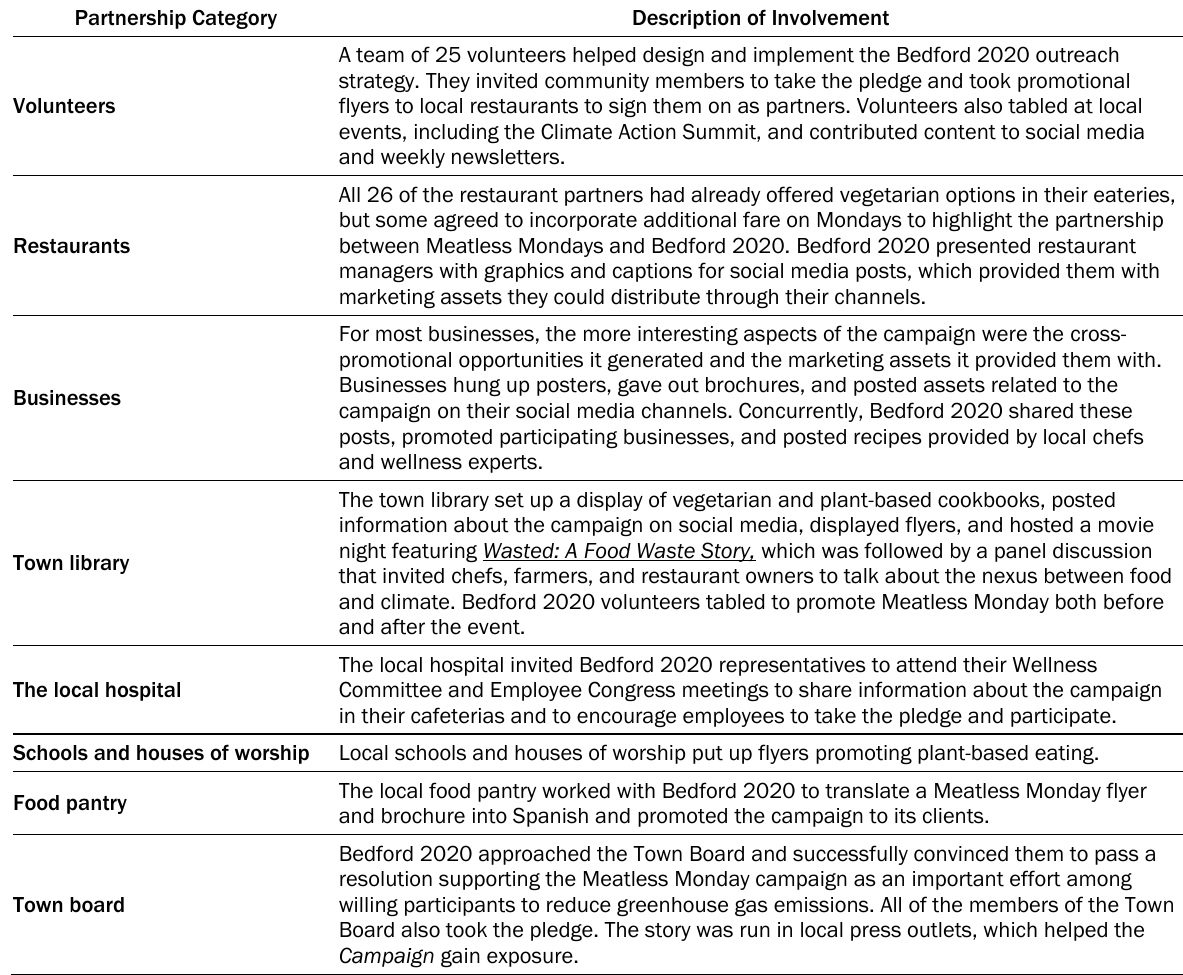
Table 1. Partners involved in the Bedford 2020 Meatless Monday